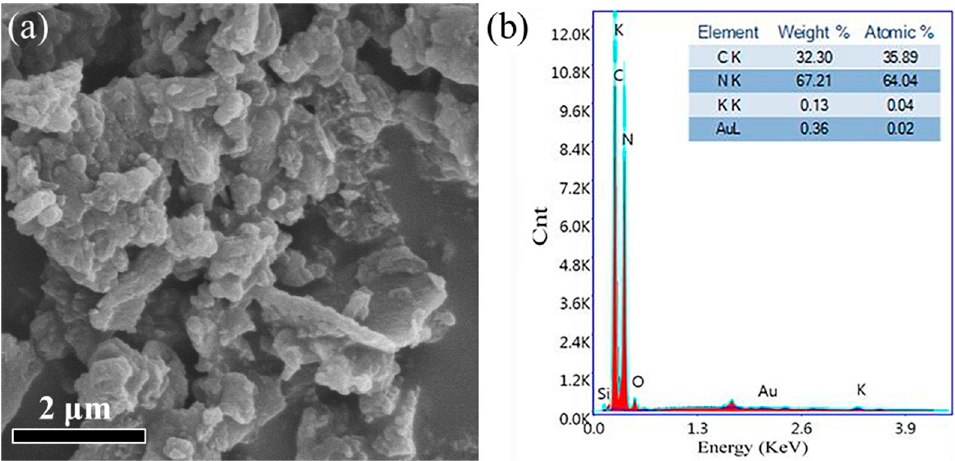
Figure 1. ( a ) Scanning electron microscopy (SEM) image of 0.05% Au/ β -cyclodextrin–carbon nitride ( β -CD-CN); ( b ) energy-dispersive spectroscopy (EDS) spectra of 0.05% Au/ β -CD-CN. The STEM images (high resolution and low resolution) of 0.05% Au/ β -CD-CN are shown in Figure 2. It can be found that Au particles are finely dispersed on the surface of β -CD-CN. The average size of Au nanoparticles is about 3 nm in diameters.